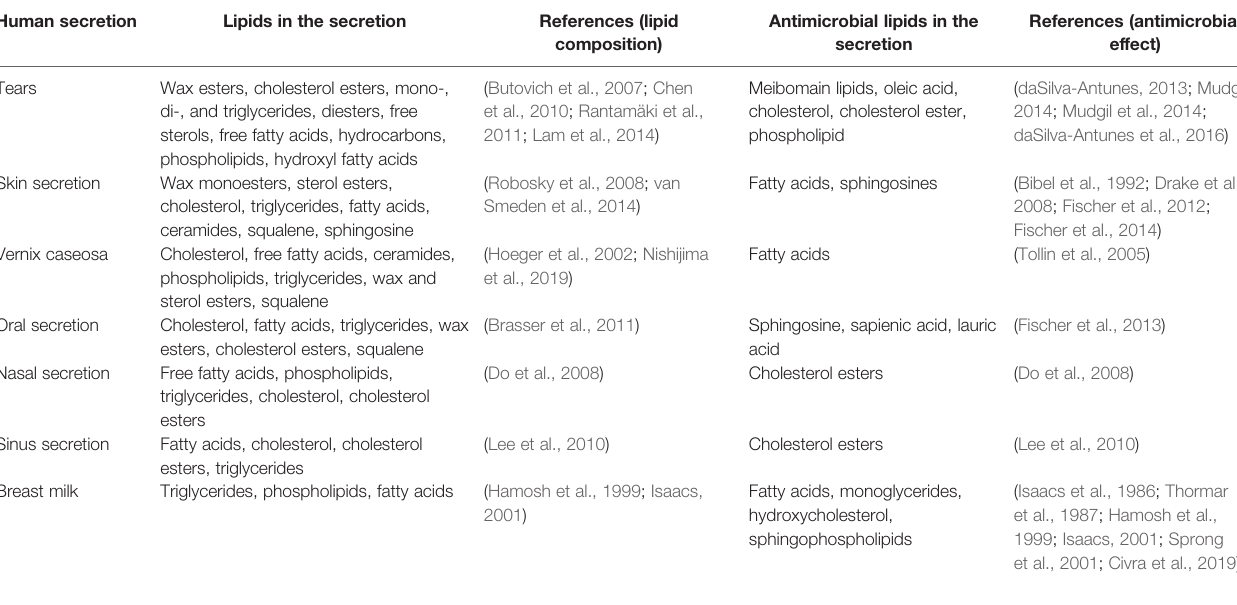
TABLE 1 | Antimicrobial lipids in human